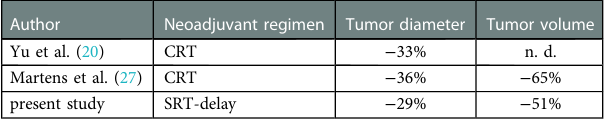
TABLE 2 Downsizing of rectal cancer following neoadjuvant therapy evaluated in restaging MRI. Reduction of tumor diameter, Regression of total tumor volume. CRT, conventional chemoradiation; SRT-delay, short-term radiotherapy with delayed surgery; n.d., not